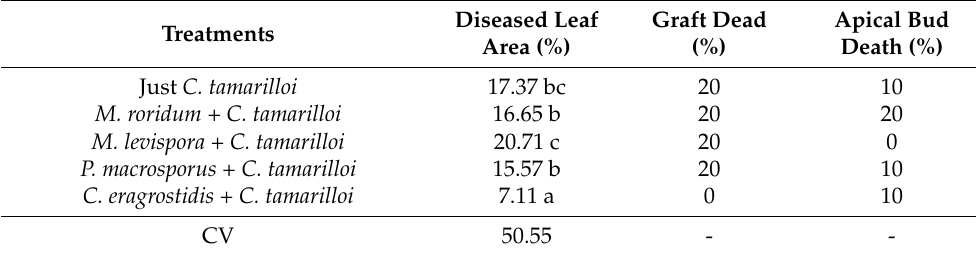
Table 2. Percentage of diseased leaf area, graft dead and apical bud death in seedlings after preven- tive treatment *.